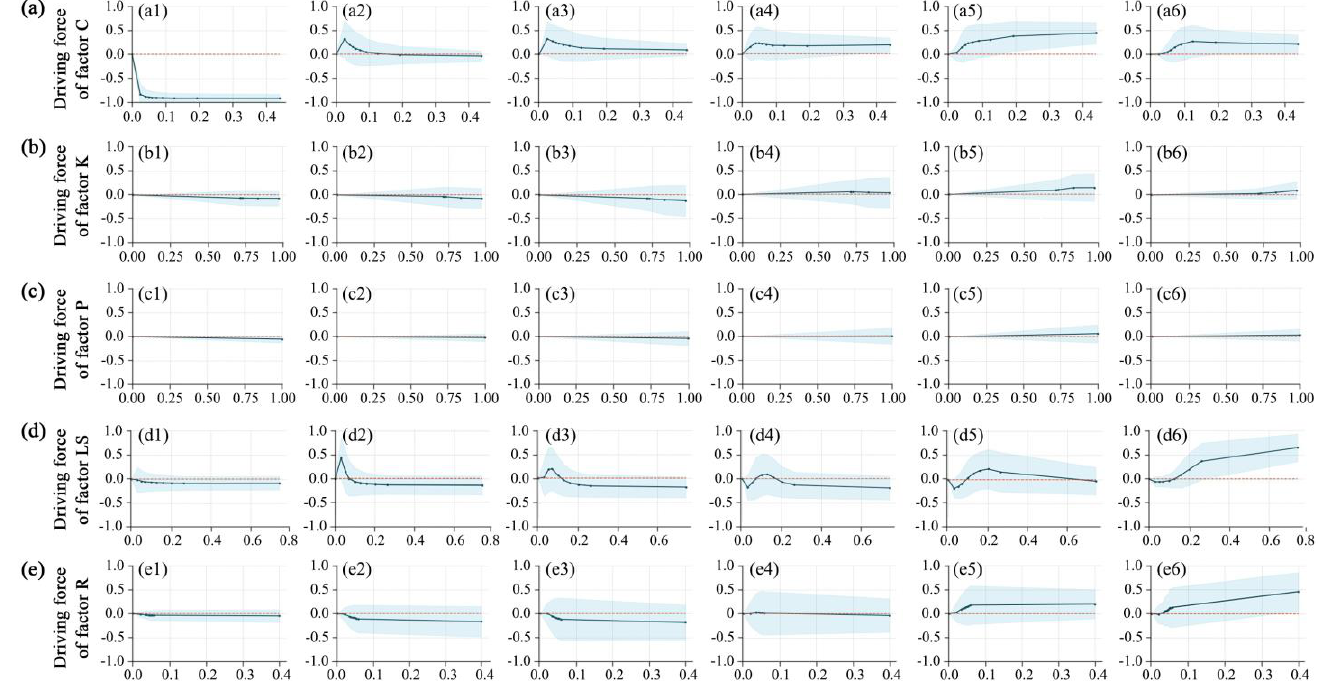
Figure 9. The PDP diagrams of each factor under different erosion intensity grades; ( a ) Cover-Man- agement Factor; ( b ) Soil Erodibility Factor; ( c ) Support Practice Factor; ( d ) Slope Length and Steep- ness Factors; ( e ) Rainfall Erosivity Factor; 1 to 6 represents the soil erosion intensity grade is very light, light, moderate, strong, very strong, and extremely strong, respectively. The y-axis represents the influence of different factors on soil erosion; positive values represent promotion, and negative values represent inhibition). The X-axis represents the range of factors. The blue shaded area indi- cates the level of confidence. The points on the lines represent the concentrated range of different factors.